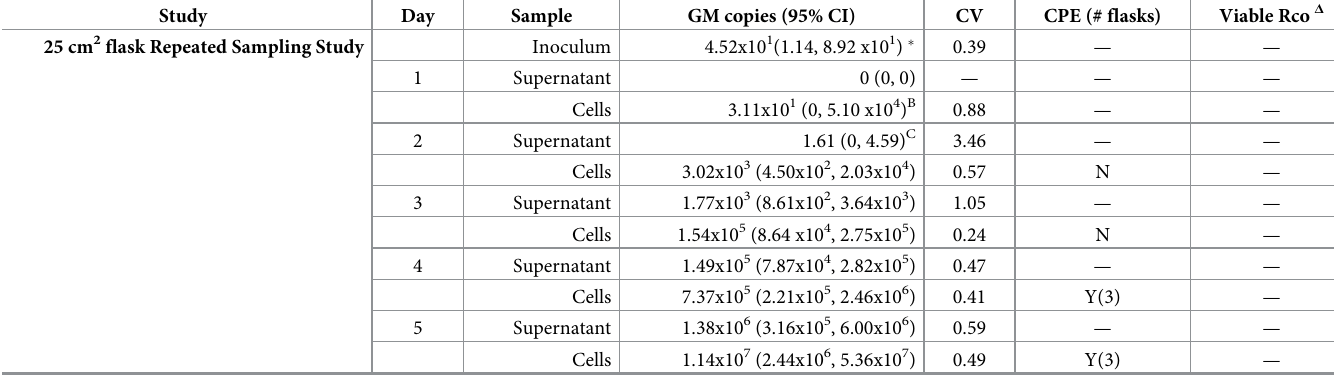
Table 1. Comparison of R . conorii in supernatant and cellular samples over time, under varying sampling and culture size conditions.